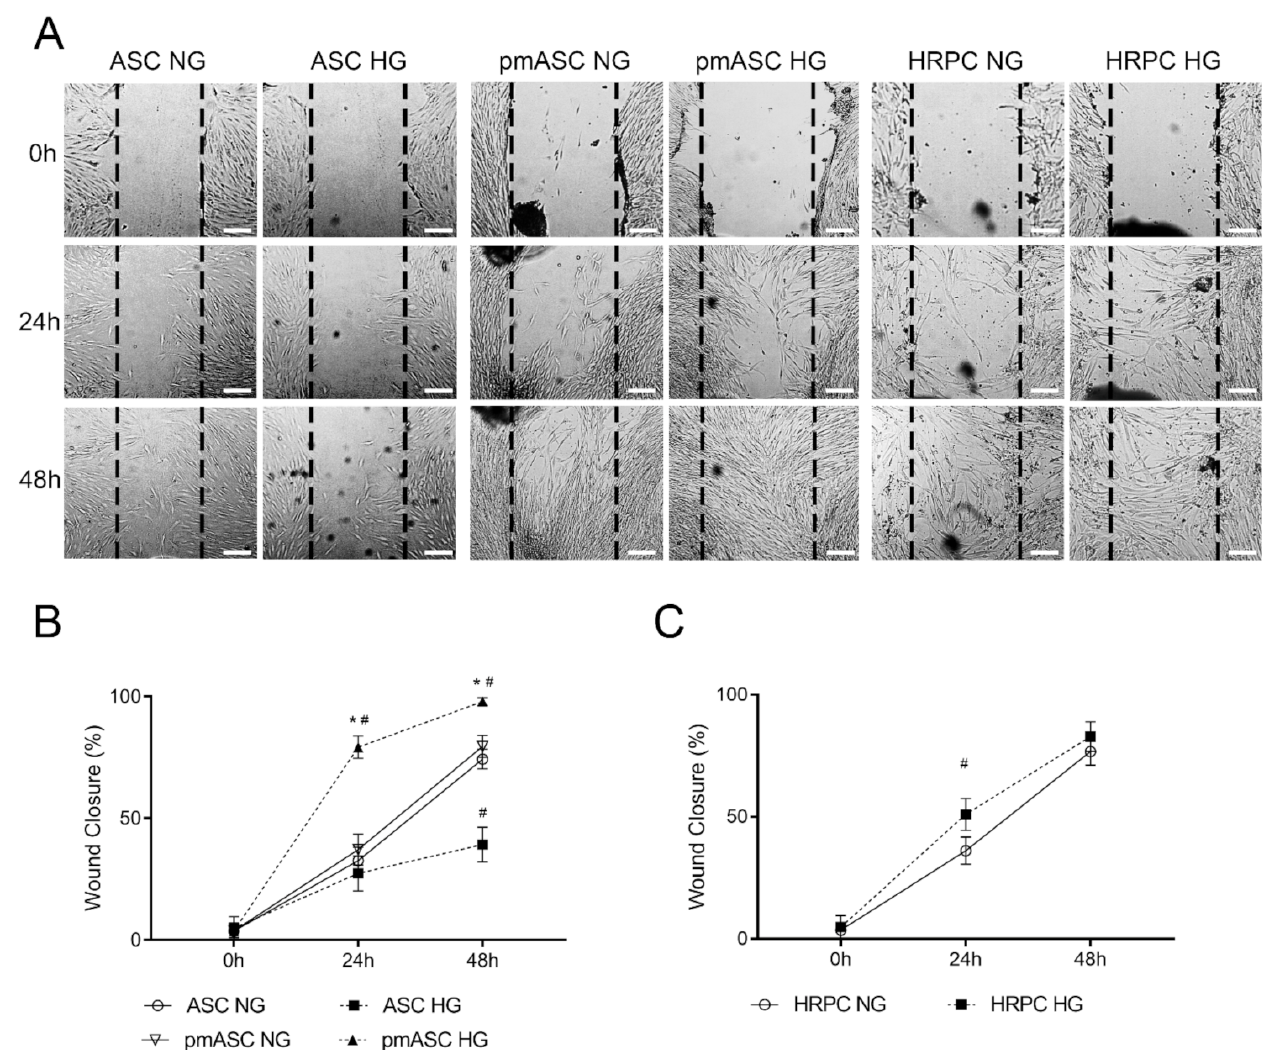
Figure 3. Cell migration ability evaluated by wound-healing assays in human adipose mesenchymal stem cells cultured in basal medium (ASC) or in pericyte medium (pmASC), and in cultures of human retinal pericytes (HRPC). In some samples of each culture type, glucose was added to the culture medium (High Glucose, 25 mM, HG) whereas other samples were kept in normal glucose (NG) condition. ( A ): Representative pictures of each sample taken immediately after the scratch (0 h), after 24 h and 48 h of culture. Scale bar: 100 µ m (Magnification: 4 × ). Percentage of wound closure was quantified by Image J software for ASC and pm ASC cultures ( B ), and HRPC cultures ( C ). Values are expressed as mean ± SEM of three independent experiments. * p < 0.05 pmASC vs. ASC; # p < 0.05 HG vs. NG. Two-way ANOVA, followed by Sidak’s